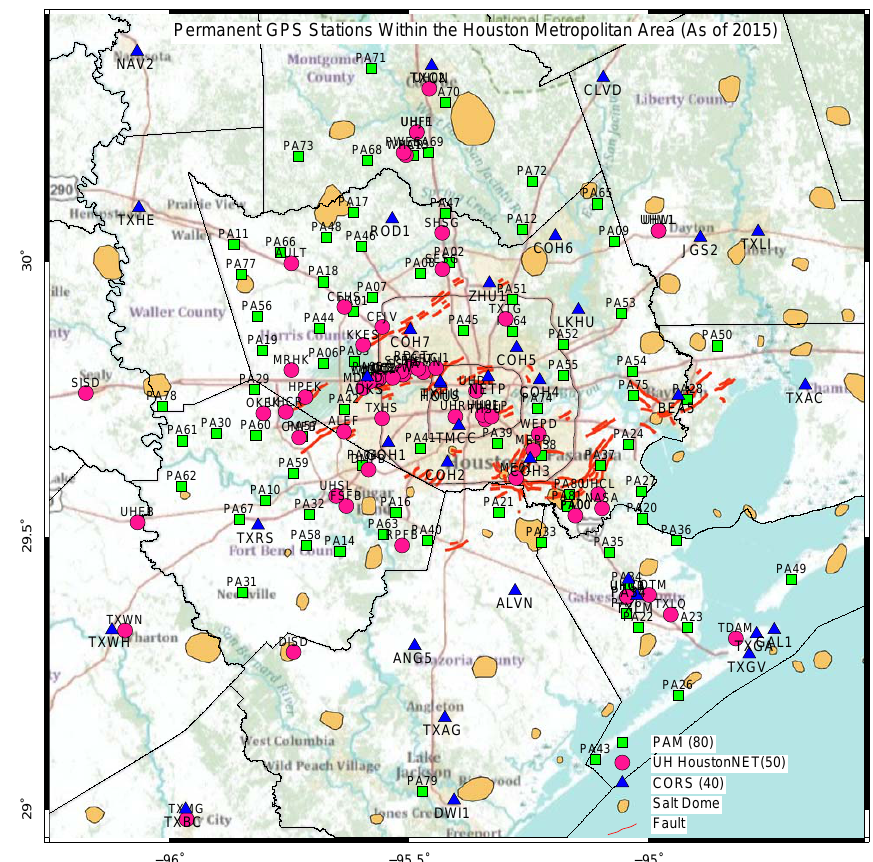
Figure 1. Map showing the locations of current permanent GPS stations within the Houston metropolitan area. The locations of salt domes and fault lines are sourced from American Association of Petroleum Geologists (2011) and from USGS (Shah and Lanning-Rush, 2005),